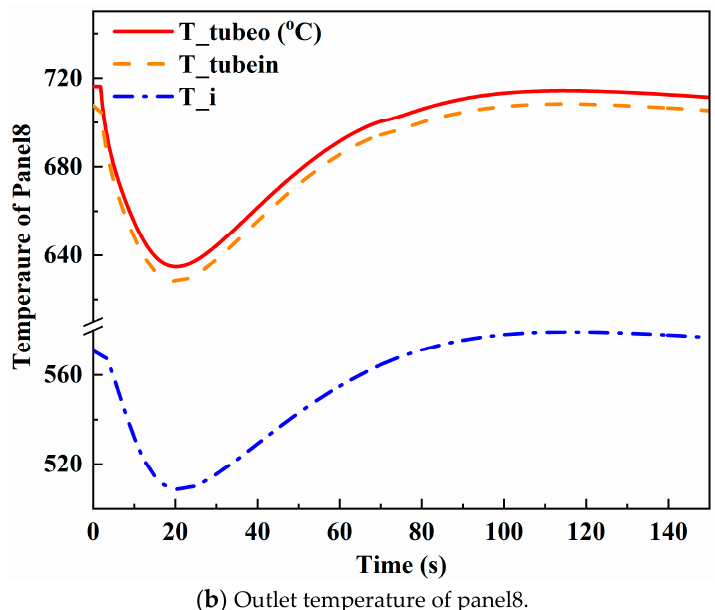
Figure 5. Influence of Step DNI disturbance (800–600 W/m 2 ).